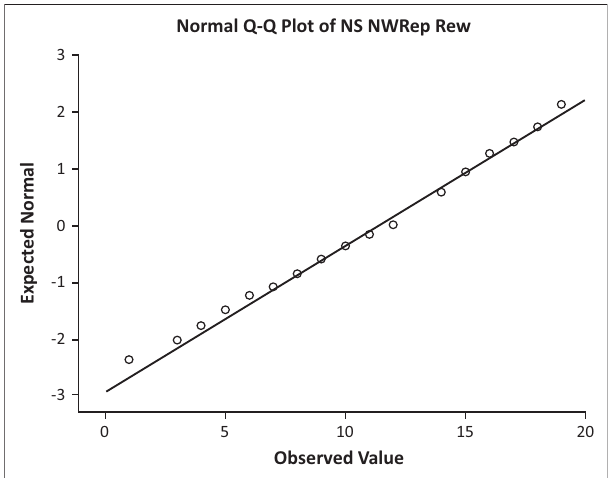
FIGURE 1: Normal Q-Q plot of NS NRT scores.